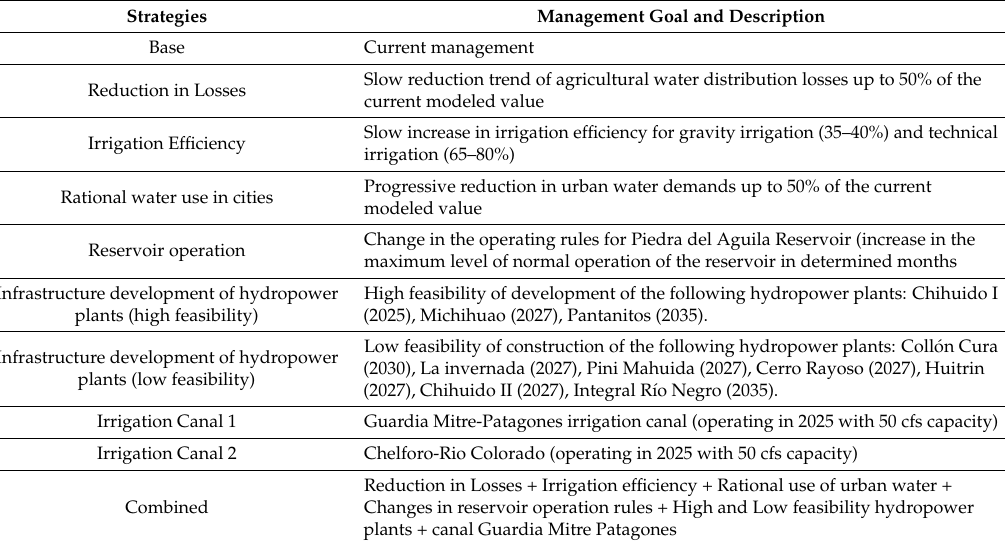
Table 5. List of Strategies (L) identified for the study area and corroborated by the local institutions.